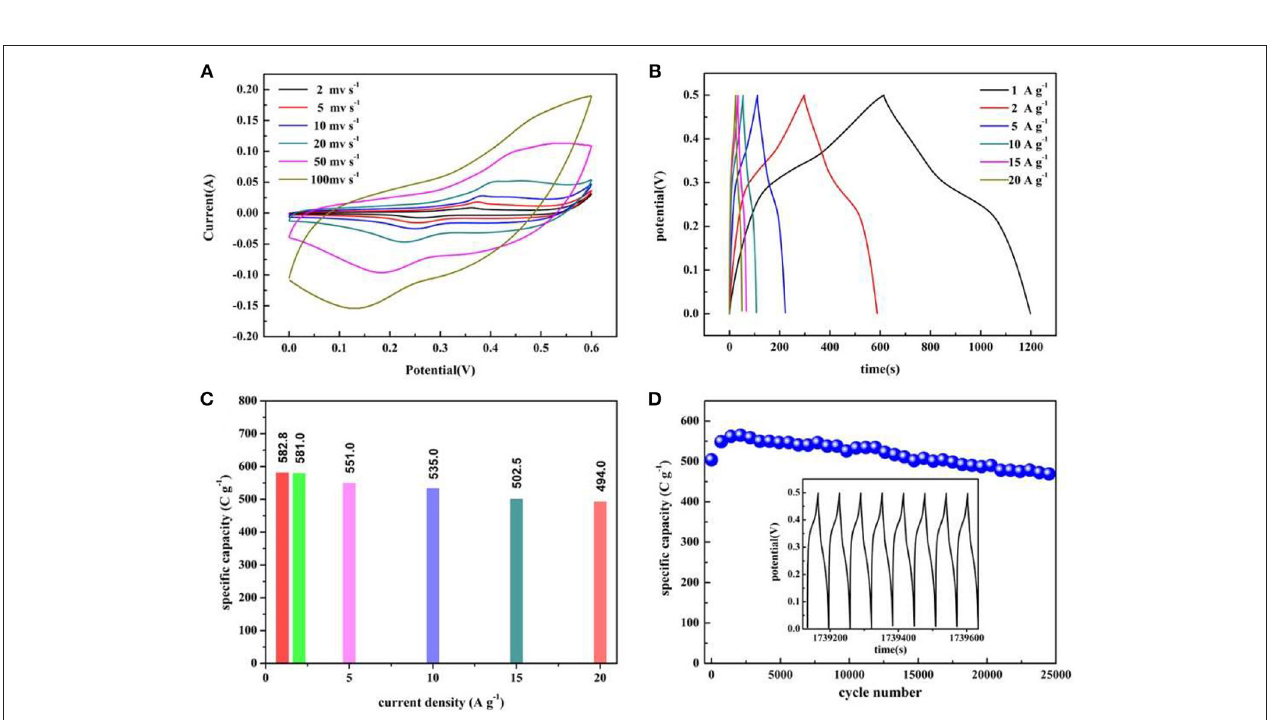
FIGURE 4 | (A) CV curves of the Co 3 O 4 NWAs electrode at various scan rates, (B) Galvanostatic charge-discharge curves of the Co 3 O 4 NWAs electrode at different current densities, (C) Specific capacitance of the Co 3 O 4 NWAs electrodes at different current densities. (D) Long-term cycling stability of the Co 3 O 4 NWAs electrode at 15A g − 1 (The inset shows the galvanostatic charge-discharge curves of the last 8 cycles).